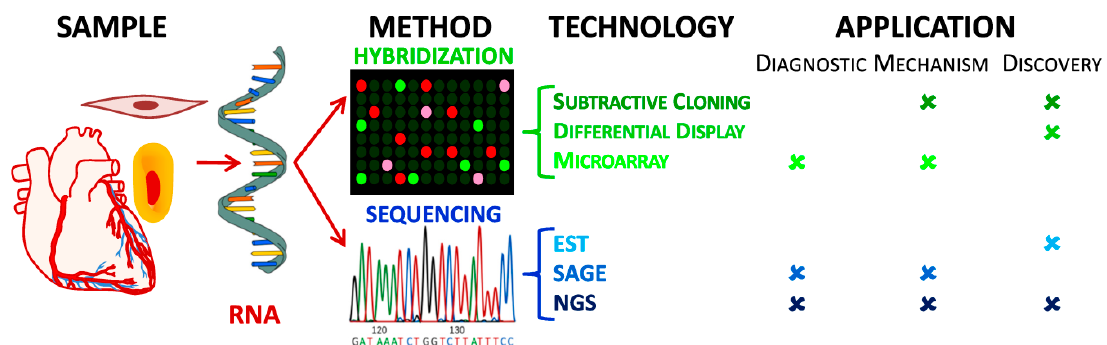
Figure 1. Transcriptomics workflow diagram highlighting the steps to process tissue, cell, or biopsy sample for RNA and choosing gene expression technology platform depending upon the specific application as an investigative tool for discovery science, disease diagnosis, or molecular mechanism. EST: expressed sequence tag; SAGE: serial analysis of gene expression; NGS: next-generation sequencing.